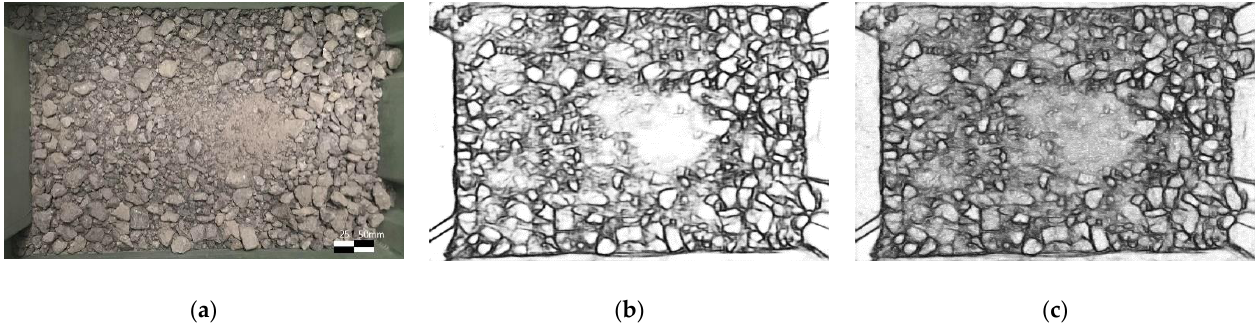
Figure 4. An example of raw image and its edge detection results: ( a ) the raw image; ( b ) the fused edge-map concatenated from upsampling blocks; ( c ) the averaged edge-map from the previous predictions.